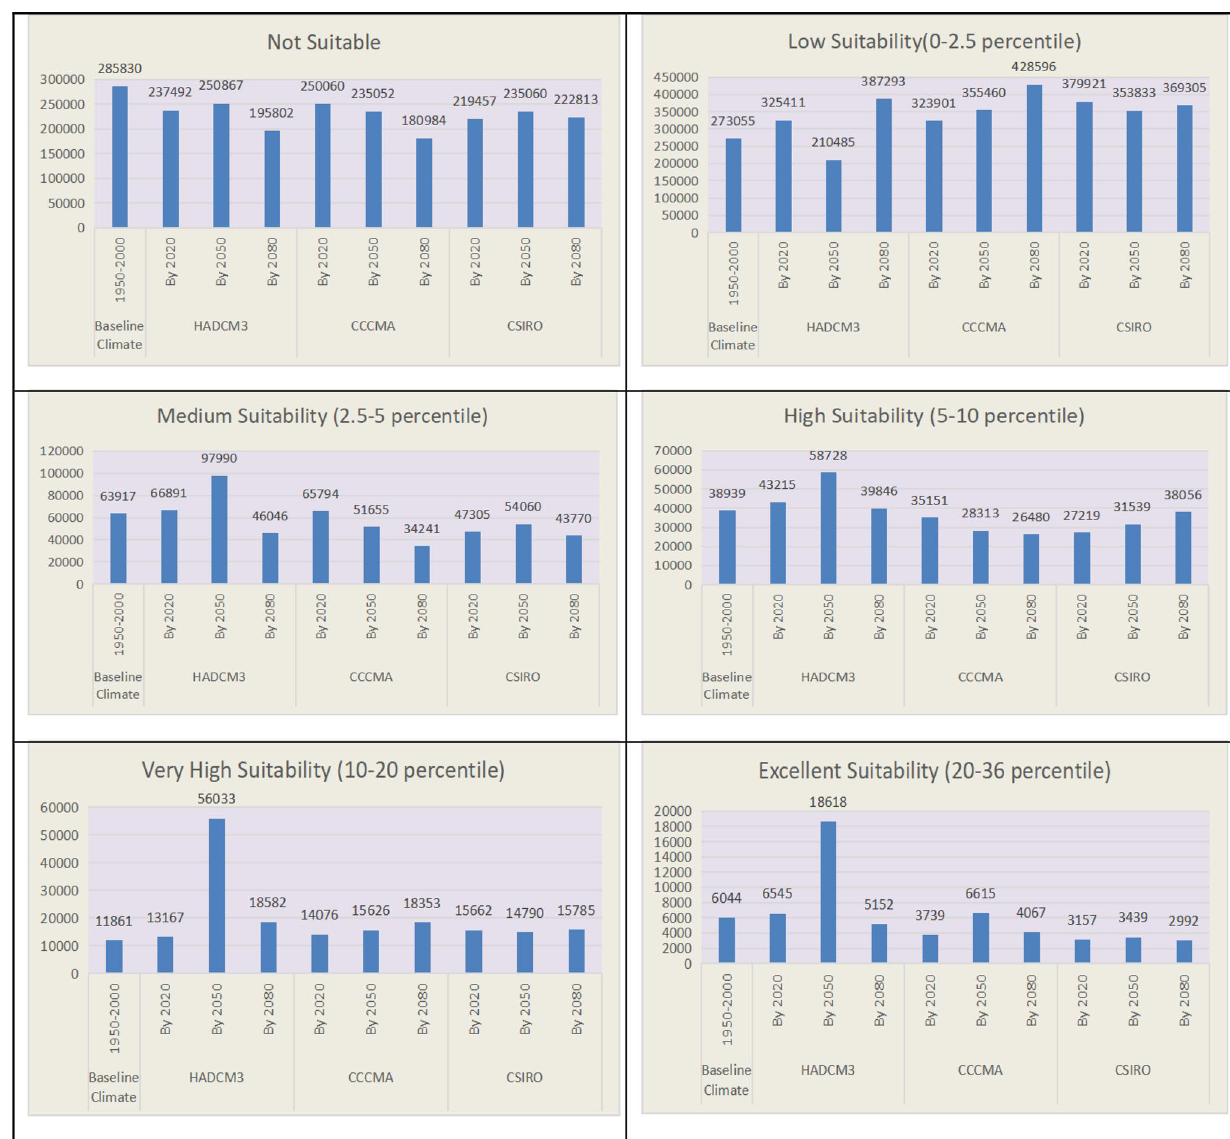
Fig. 6 BIOCLIM predicted areas of non-suitability, areas of low suitability, medium, high, very high and excellent suitability malaria vectors’ habitats from baseline climate, HADCM3, CCCMA and CSIRO